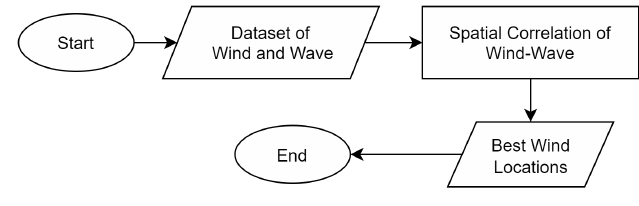
Figure 9. Flowchart for exploratory data.